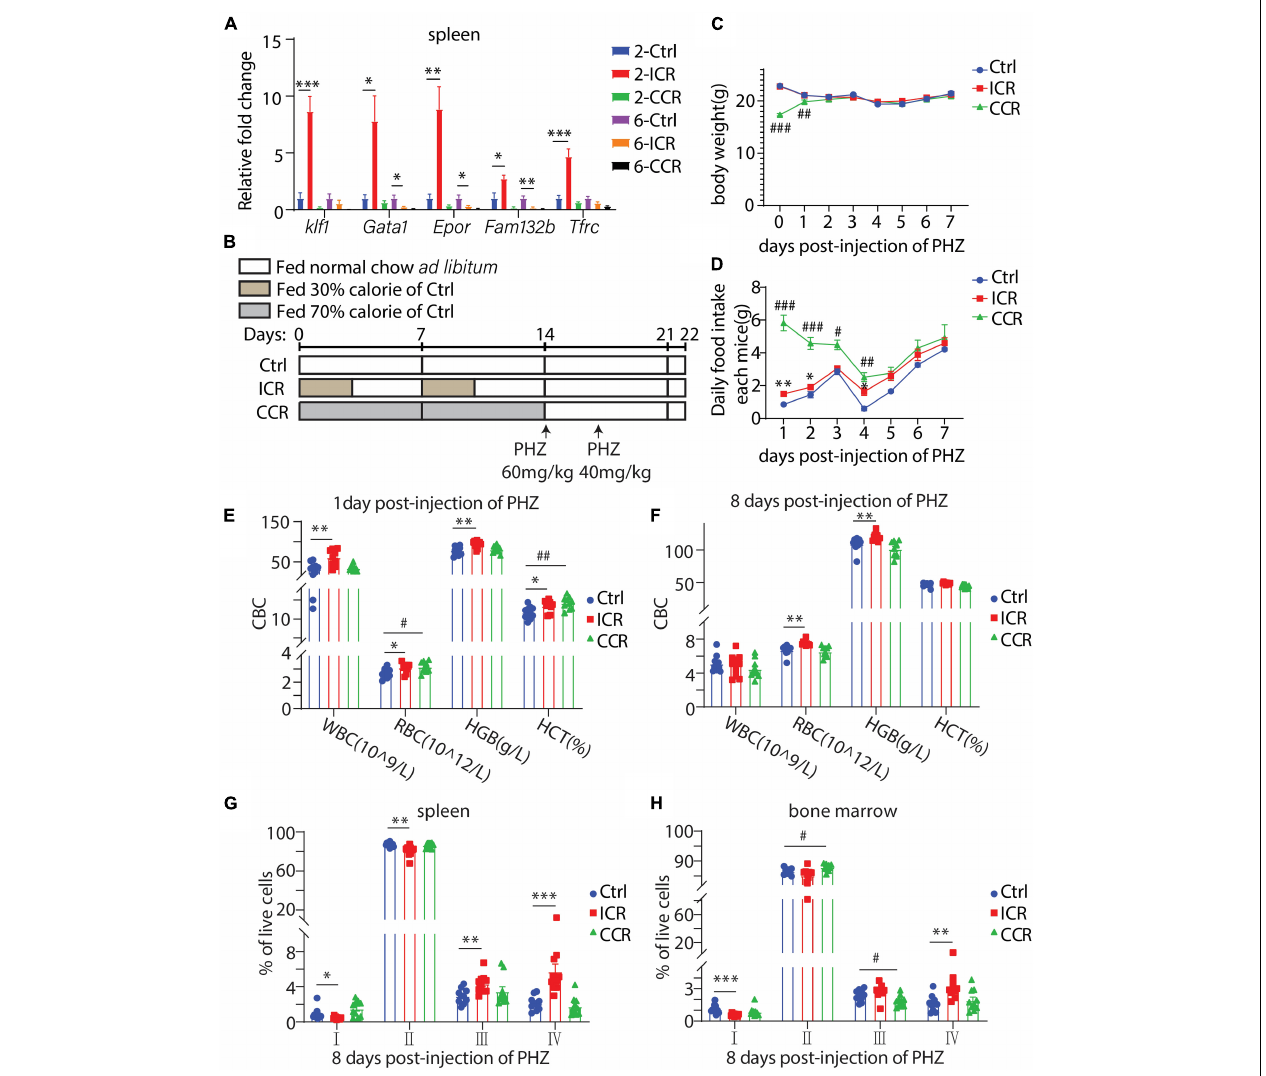
FIGURE 4 | Effect of CR on acute hemolytic anemia induced by PHZ in mice. (A) Gene expression levels of crucial genes involved in erythrocyte development in the spleen under a short-term or long-term CR for Figures 2 , 3 ( n = 6 for each group). (B) Design of the experiment. Seven-week-old male C57BL/6 mice were divided into three groups ( n = 10 for each group). The mice were i.p. injected with 60 mg/kg and 40 mg/kg PHZ, respectively, on the first and third days after the end of CR. All mice were fed normal chow ad libitum since receiving PHZ. (C,D) Body weight and food intake of the mice post-injection of PHZ. (E,F) Blood count of the mice using peripheral blood. (G,H) The proportion of erythroid cells at different stages in the spleen and bone marrow. All the data are presented as mean ± S.E.M. ∗ P < 0.05, ∗∗ P < 0.01, ∗∗∗ P < 0.001 for difference between control and intermittent CR groups. # P < 0.05, ## P < 0.01, ### P < 0.001 for difference between control and continuous CR